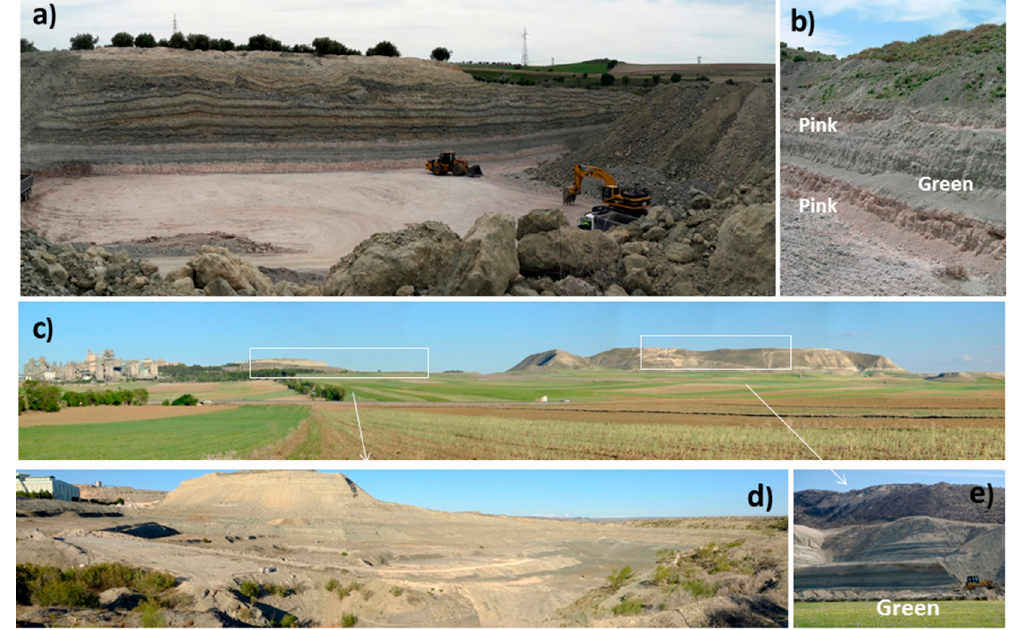
Figure 4. Representative images from Tajo Basin quarries. ( a ) Representative view of the Esquivias– Seseña quarries: note the alternation of green and pink clays at bottom of the quarry. ( b ) Detailed photograph of the green and pink colors of the bentonitic levels. ( c ) General view of the del Águila and Magán Hills. ( d ) Quarry at the bottom of del Águila Hill and ( e ) Quarry at the bottom of Magán